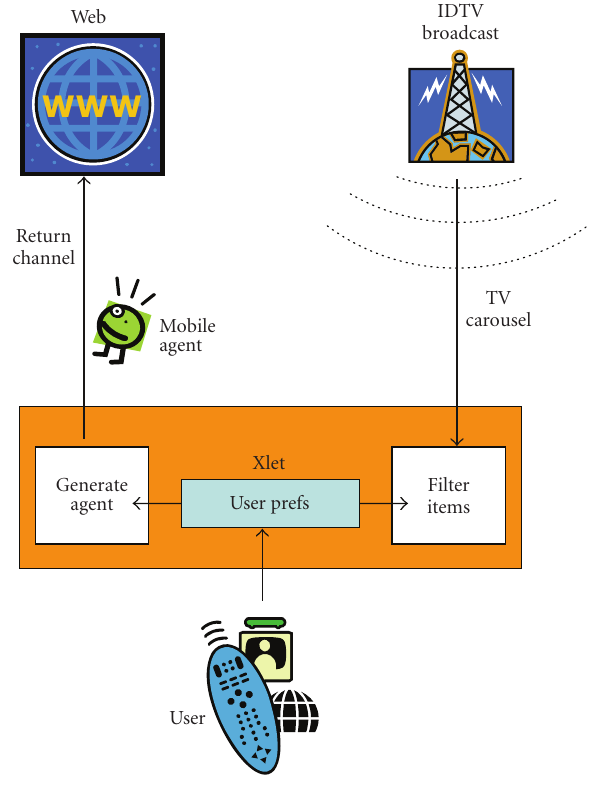
Figure 2: Xlets interaction with IDTV and the